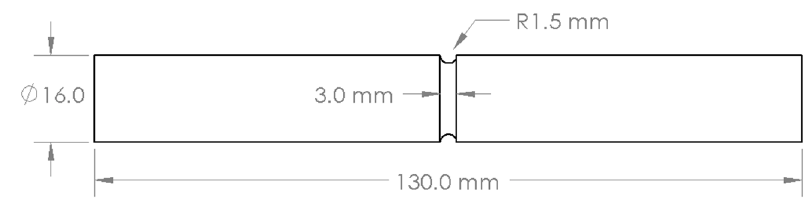
Figure 4. Geometry and sizes of U-notched specimens.